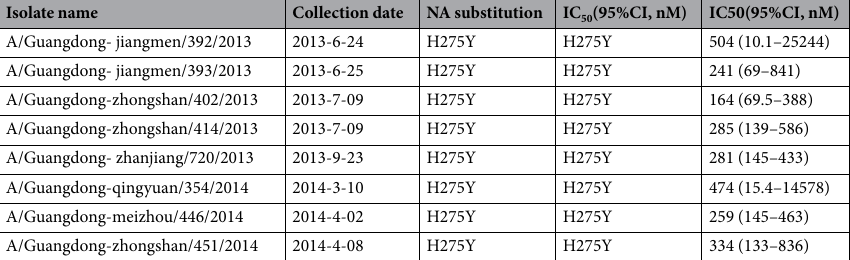
Amino acid position of the NA gene